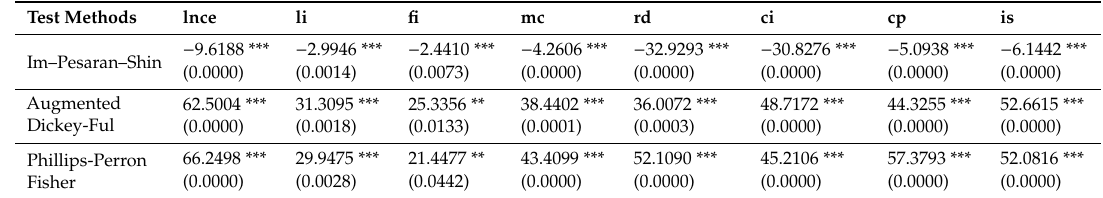
Table 2. Unit root test results.